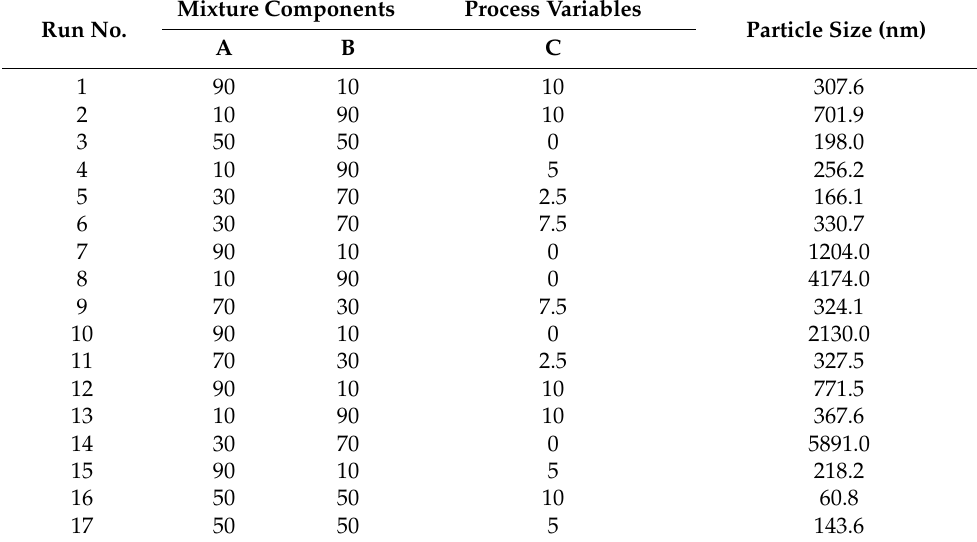
Table 2. The variables’ levels and the observed responses of luliconazole spanlastics runs. Run